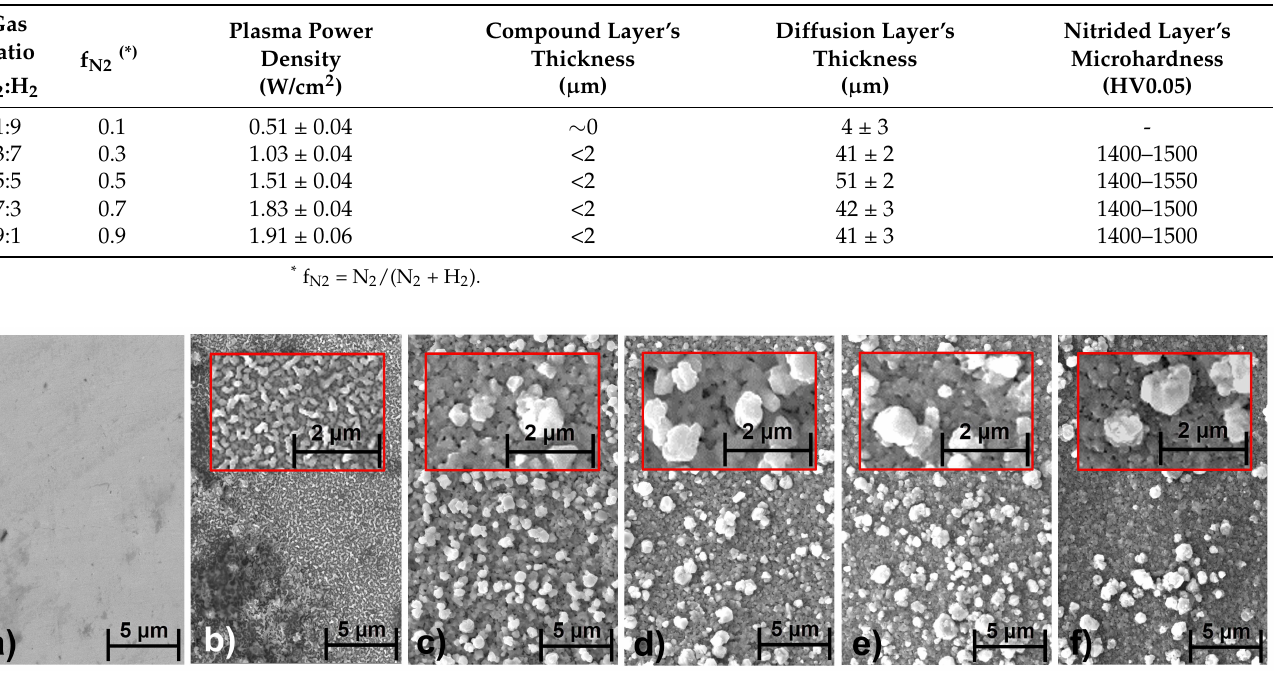
Figure 3. Scanning electron microscopic images of the surface of non-nitrided and nitrided samples applying different N 2 –H 2 ratios within the plasma process of FeAl40 alloy: ( a ) polished and non- nitrided, ( b ) f N2 = 0.1, ( c ) 0.3, ( d ) 0.5, ( e ) 0.7 and ( f )